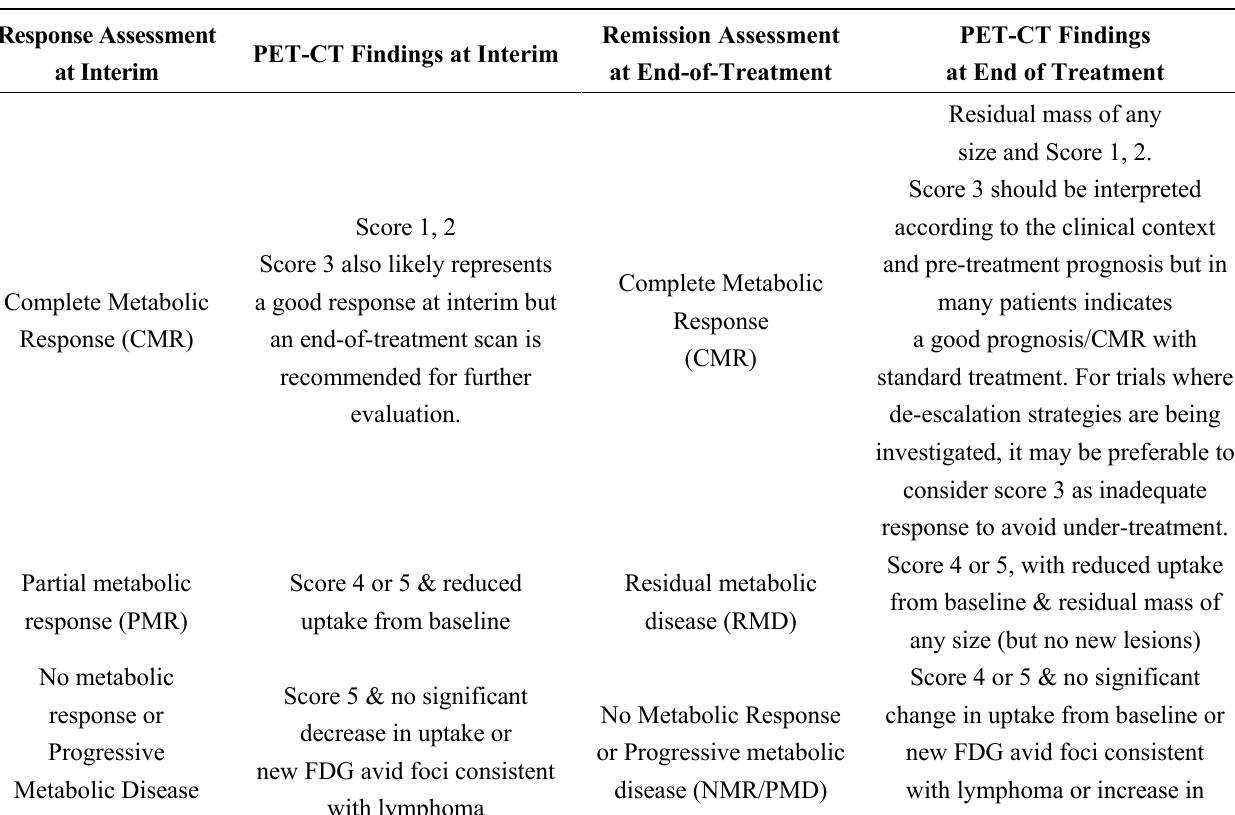
Table 3. New Lugano